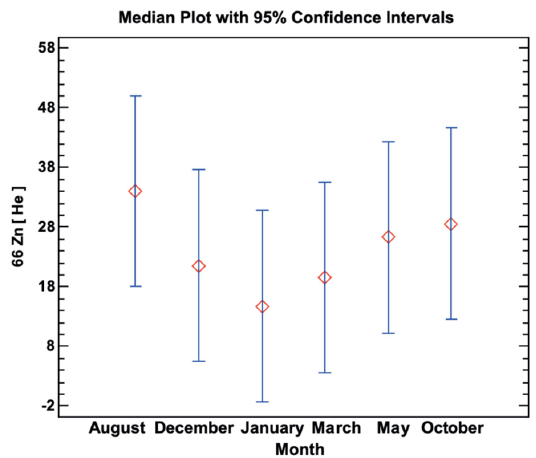
Figure 5. Graph of interactions between the month and the sampling point for the concentration of heavy metals.